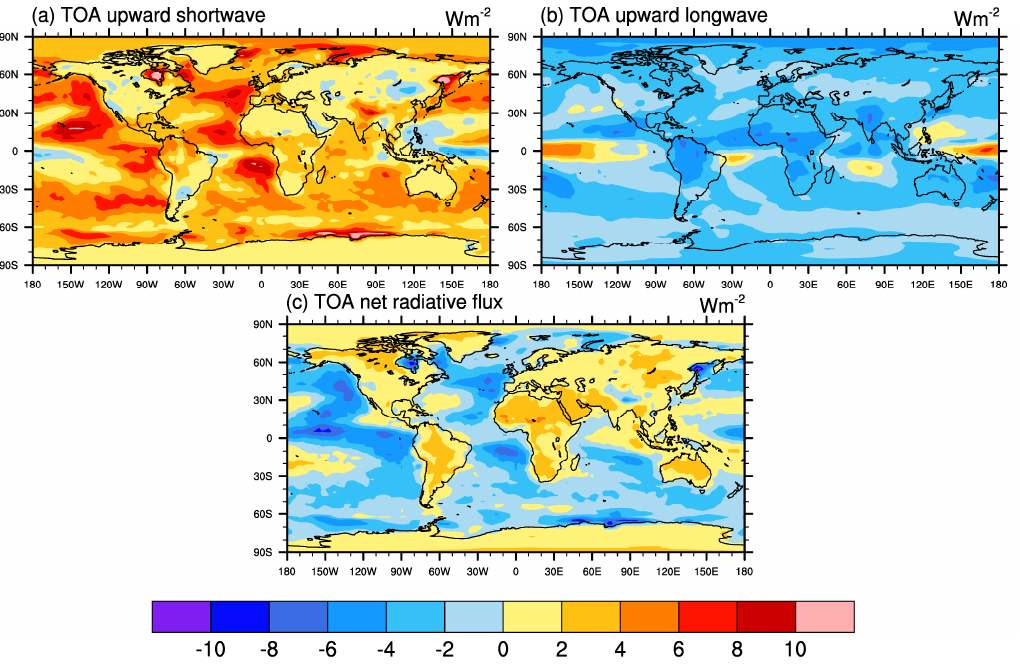
Figure 1. Geographical distribution of the di ff erence of ( a ) top of the atmosphere (TOA) upward shortwave radiation, ( b ) TOA upward longwave radiation, and ( c ) TOA net radiative flux between G4cdnc and RCP4.5 during the progress period. Results are shown for multi-model ensemble mean. Overall, the changes in the upward shortwave radiation and OLR tend to compensate each other.